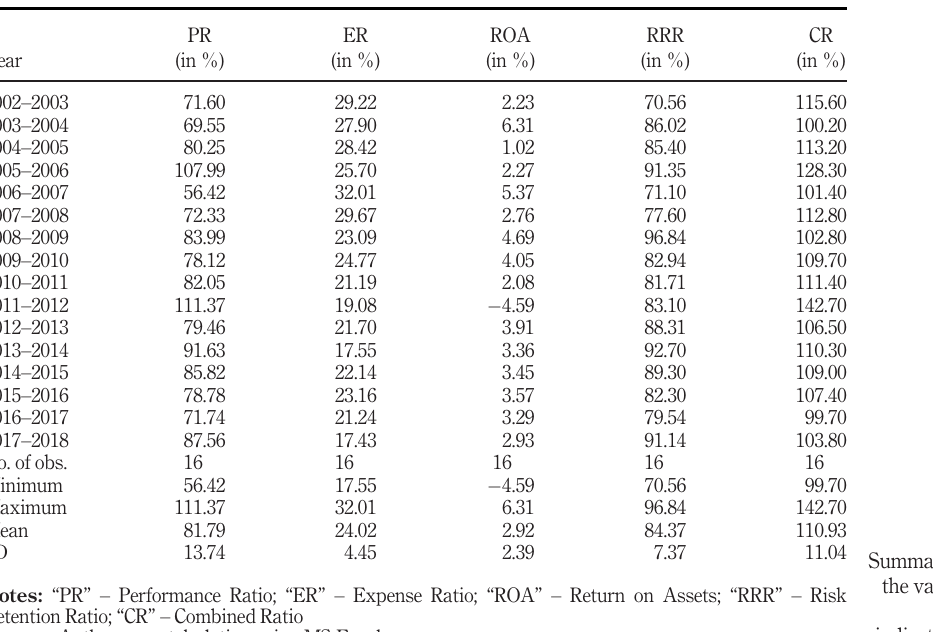
Table 2. Summary statistic